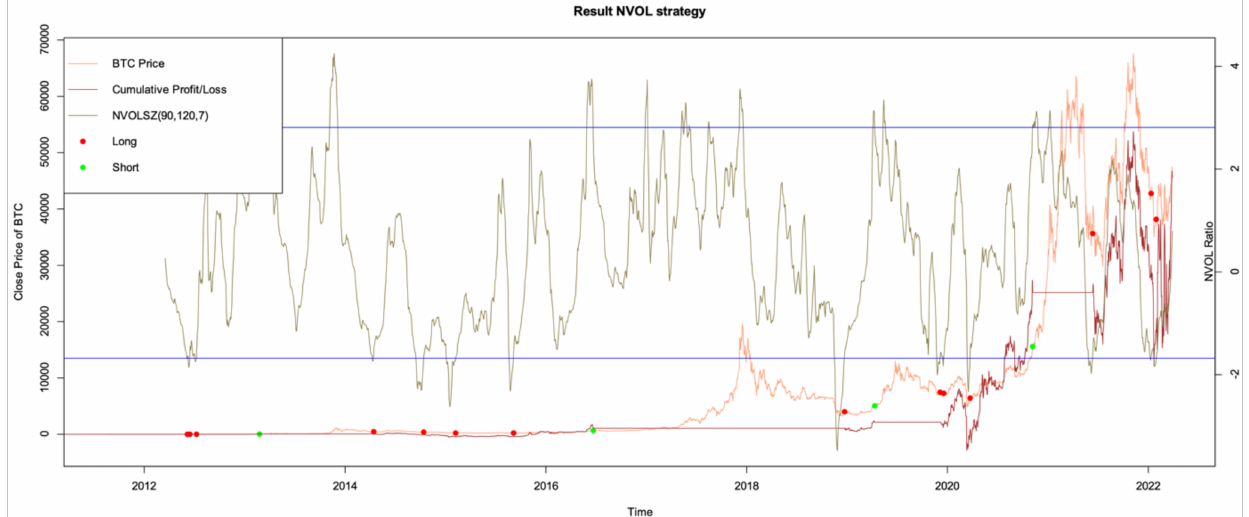
Figure A5. NVOLS-Z strategy: BTC price (orange line, left-hand side), cumulative profit/loss (red line, left-hand side), NVOL S-Z ratio (brown line, right-hand side), long and short thresholds (blue lines, right-hand side), long orders (red points), and short orders (green points).